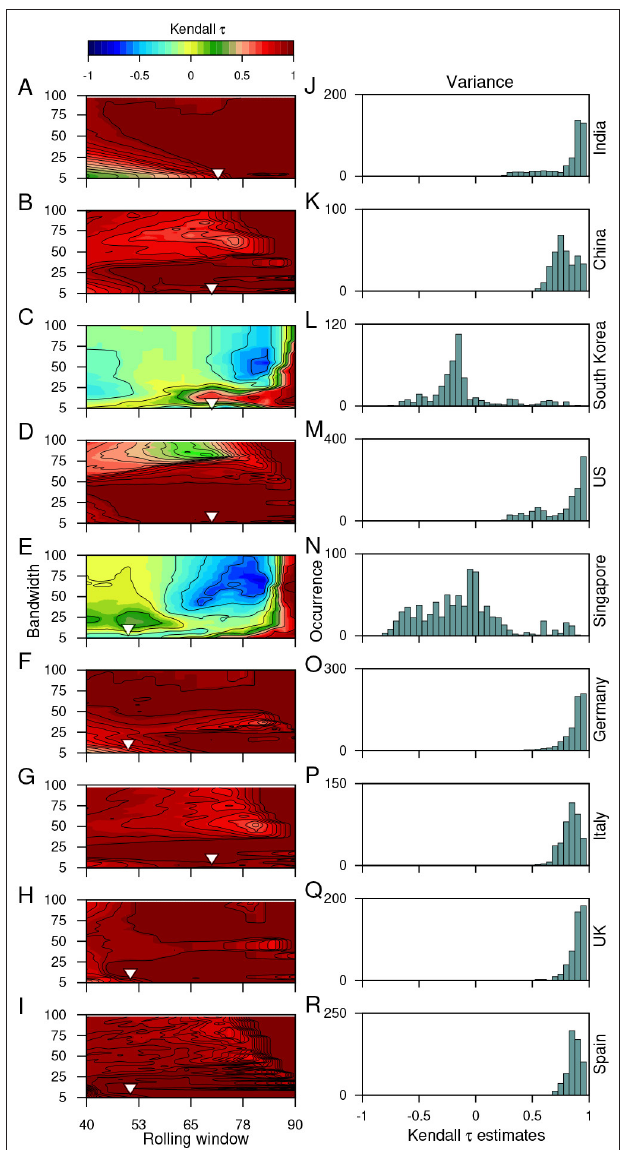
FIGURE 4 | The sensitivity of the choice of the rolling window size and the filtering bandwidth to estimate the EWSs. (A-I) : Contour plots demonstrate the effect of moving window size and the filtering bandwidth on the trends observed while calculating the changes in the variance of the time series, using the Kendall- τ test statistic. (J-R) : Panels on right show the frequency distribution of the trend statistic. The inverted arrows mark the choice of the filtering bandwidth and moving window size used to capture the trends in the variance of the time series data.